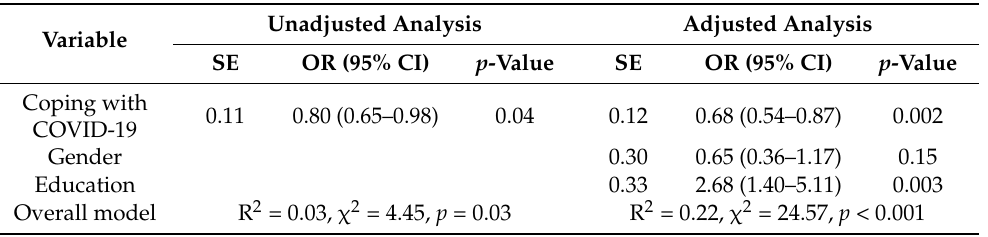
Table 5 indicates decreased odds of SHB for individuals who had lower scores on coping with COVID-19 compared to individuals with higher scores; the result remained sig- nificant after adjusting for gender and education (OR 0.68, 95% CI: 0.54–0.87). Nagelkerke’s pseudo-R 2 of the adjusted model was 22%, and the model was significant at p < 0.001. Table 5. Association between coping with COVID-19 pandemic and sustained health behavior among working-age people aged 19–65 years. Unadjusted Analysis Adjusted Analysis Variable SE OR (95% CI) p -Value SE OR (95% CI) p -Value Coping with 0.11 0.80 (0.65–0.98) 0.04 COVID-19